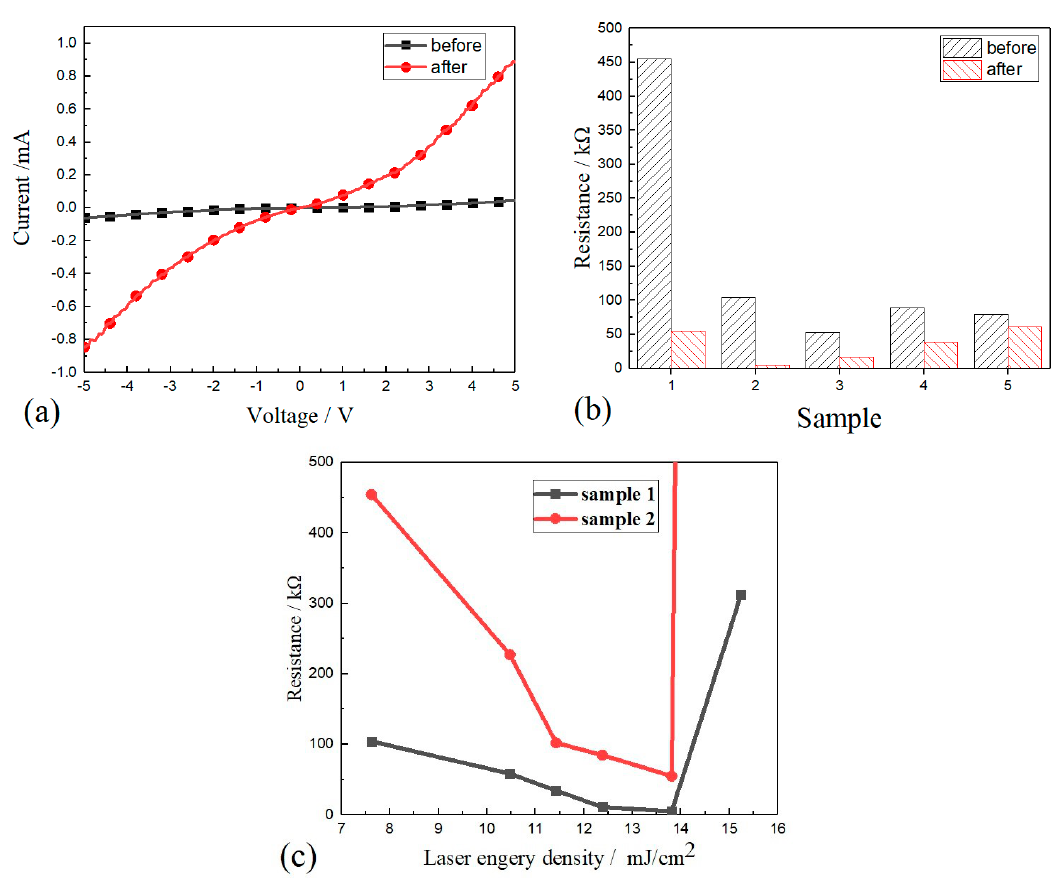
Figure 4. ( a ) I-V curve before and after laser irradiation, it can be clearly seen that the current increases, indicating that the contact resistance of SWCNTs and the electrodes can be greatly reduced after laser irradiation; ( b ) the resistance change of multiple samples before and after laser irradiation, resistance. There are different degrees of decline; ( c ) the change trend of resistance under different laser energy irradiation.